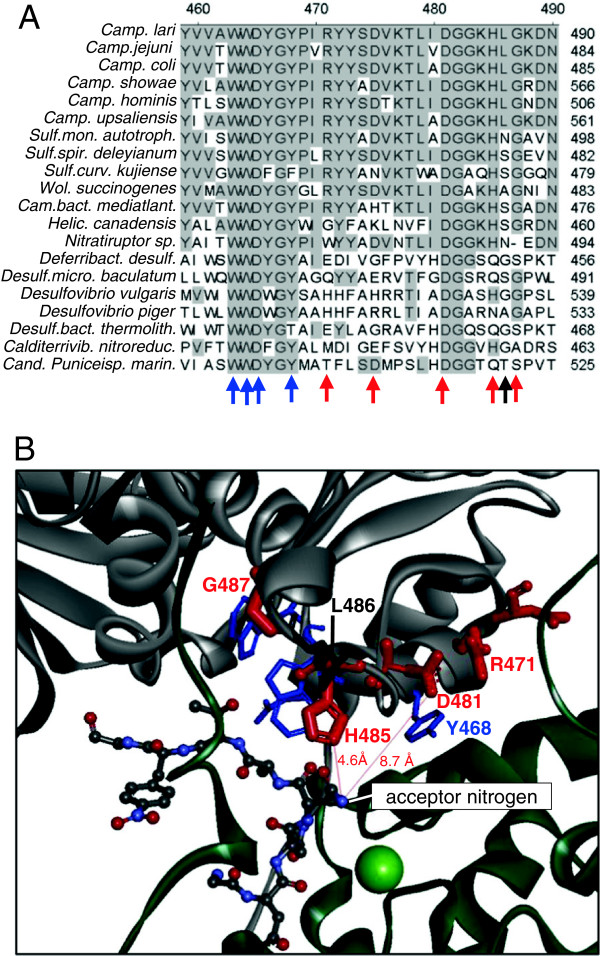
Structural context of inactivating mutations close to the WWDYG motif. (A) Alignment of bacterial PglB sequences in the region covering the C. jejuni W457WDYG461 motif to C. jejuni G481. Numbering of ruler according to PglBC. lari, conserved residues shaded, residues shown in B marked by arrows. (B) Position of activity-relevant residues which were identified by epPCR of PglBCj in the crystal structure 3RCE of PglBC. lari (bold red) [11]. The WWD residues and conserved Y468 are shown in blue. Non-conserved, mutation-tolerant residue L486 (C. jejuni L480) is shown in black. Backbone structures of the periplasmic domain and membrane domains are shown in grey and dark green, respectively. The bound bound D-Q-N-A-T-p-nitrophenylalanine acceptor peptide is given as atom-coloured ball-stick representation (N = position 0) and the coordinated Mg2+ ion is shown in light green.